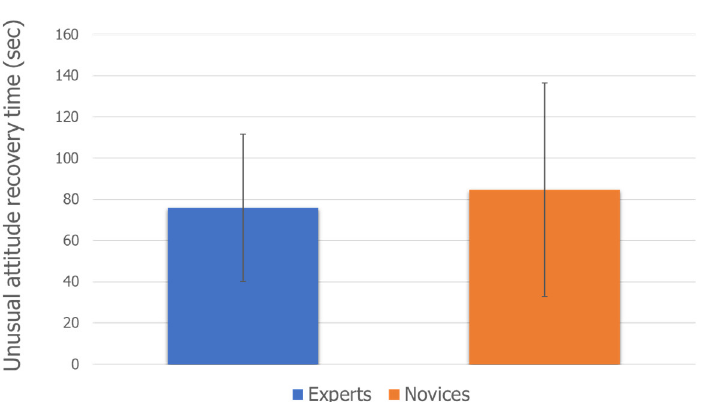
Figure 2. Median time (in sec) of the Experts (blue bar) and Novices (orange bar) in realizing and recovering the three unusual attitudes (nose-down, nose-up, and spin). No statistical difference ( p = 0.73) was found between the two groups.